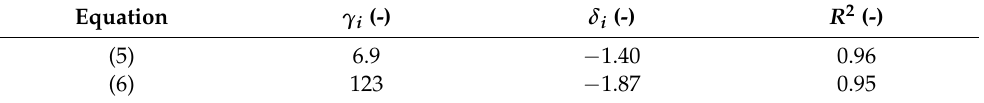
Table 2. Optimized parameters of Equations (5) and (6) for the prediction of the restitution coefficient. Equation